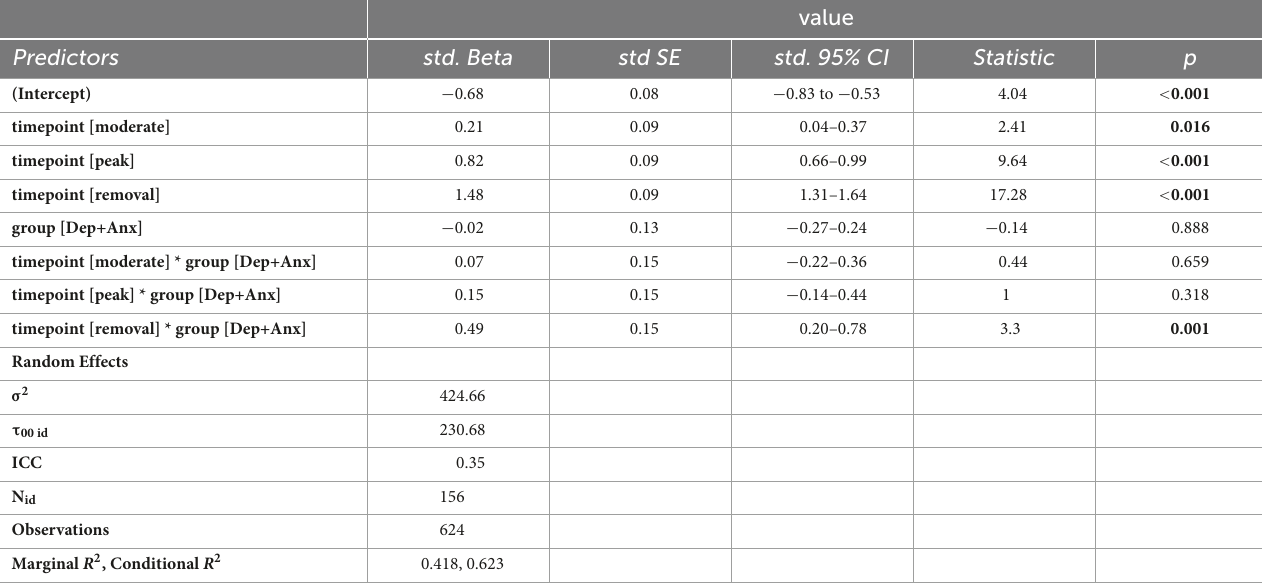
TABLE 3 Model parameters from the LME model for the Cold-Pressor